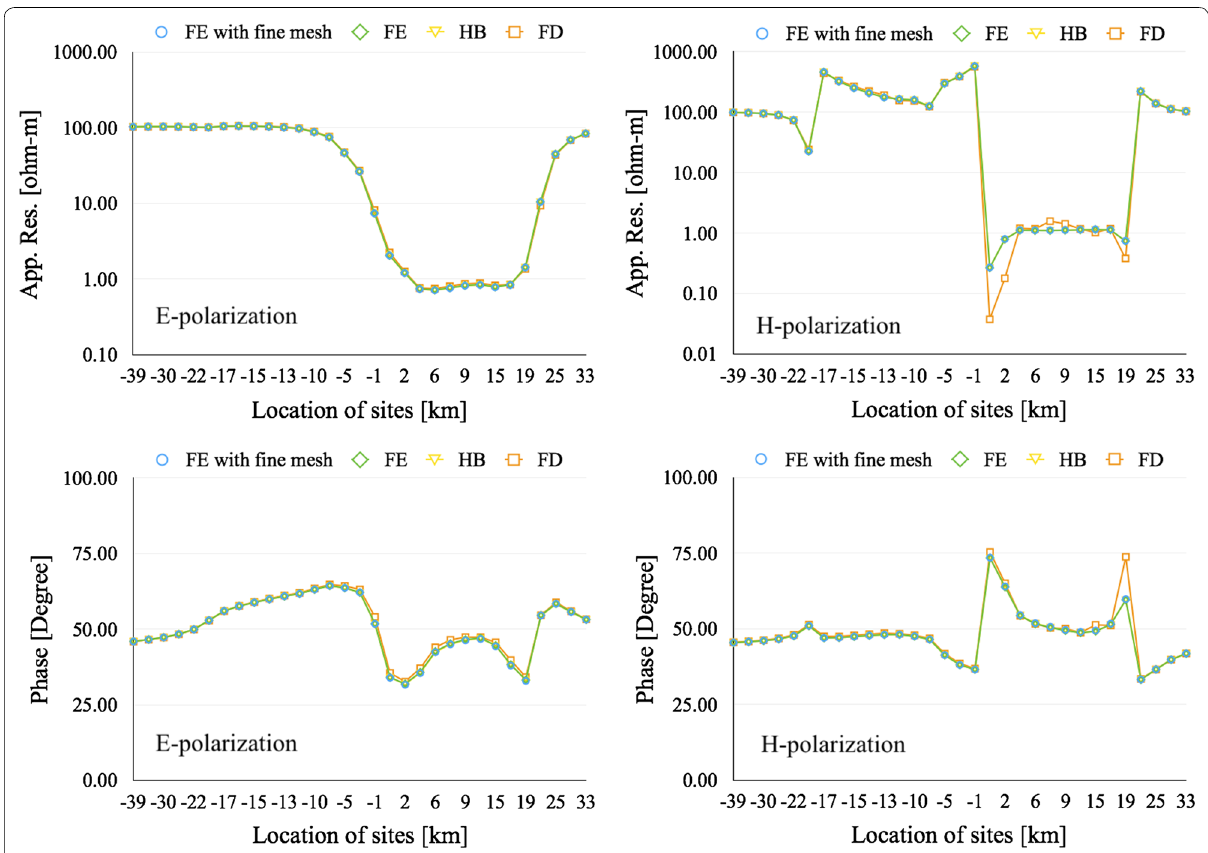
Fig. 9 Comparison of the apparent resistivity and phases calculated by the four numerical methods at T = 10s for the topographic model: FE with fine mesh (circle), FE (diamond), HB (triangle) and FD (square) methods. The apparent resistivities for the E - and H -polarizations are at the left and right top, respectively, whereas the phases for the E - and H -polarizations are at the left and right bottom,